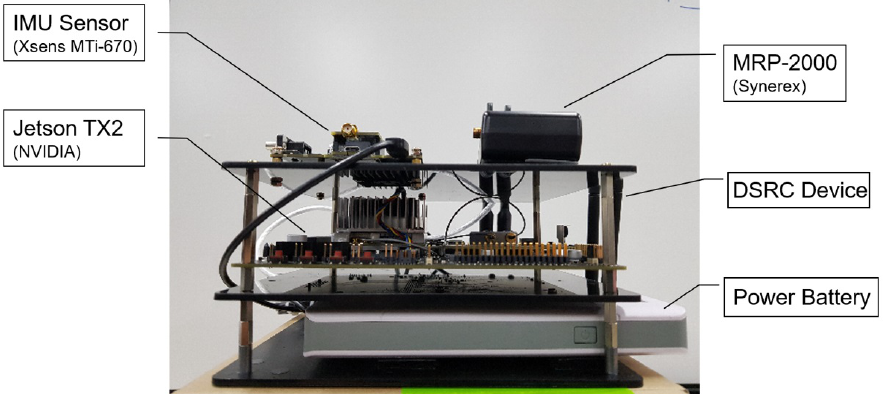
Figure 12. Four-layer CNN-2 stacked LSTM-V2X